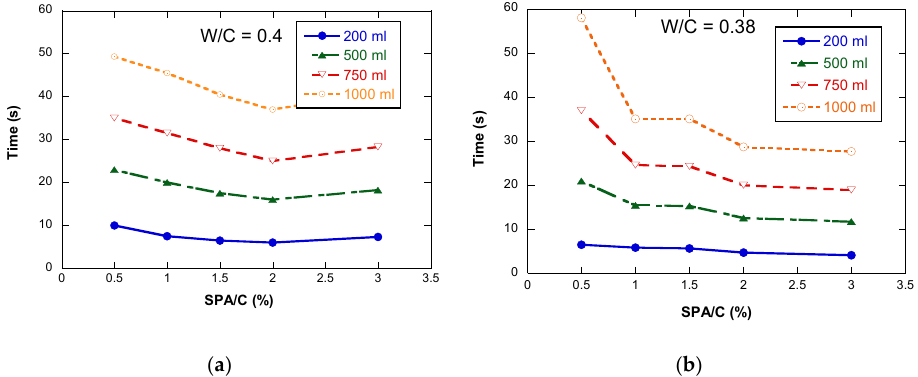
Figure 7. Marsh cone test for volumes of 200, 500, 750 and 1000 mL in case of w/c = 0.4 ( a ) and w/c = 0.38 ( b ). Appl. Sci. 2020 , 10 , x FOR PEER REVIEW